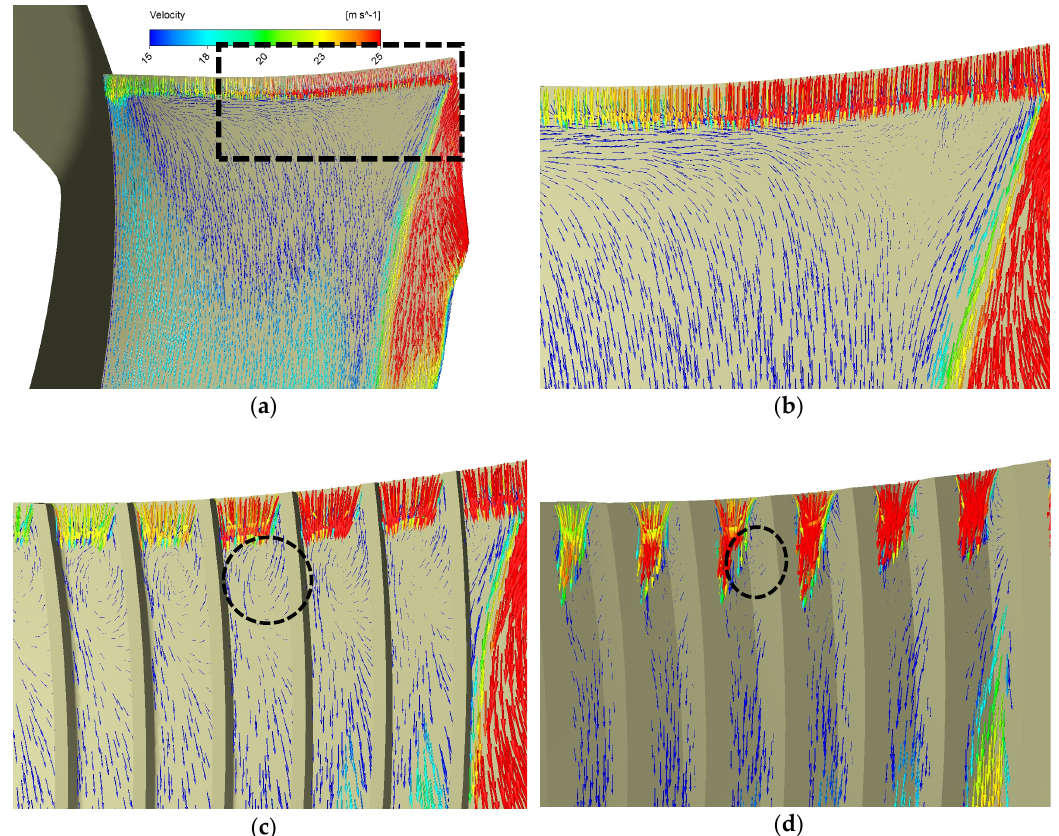
Figure 12. Velocity vectors (in rotational frame) projected on Off_Suc_1 mm: ( a ) Exaggerated region illustration, ( b ) Basic, ( c ) Rib N9 H4.2, ( d ) Wavy N9 H3. The rectangle region in ( a ) is exaggerated as in other figures and the circles denote the locations of vortices generated.